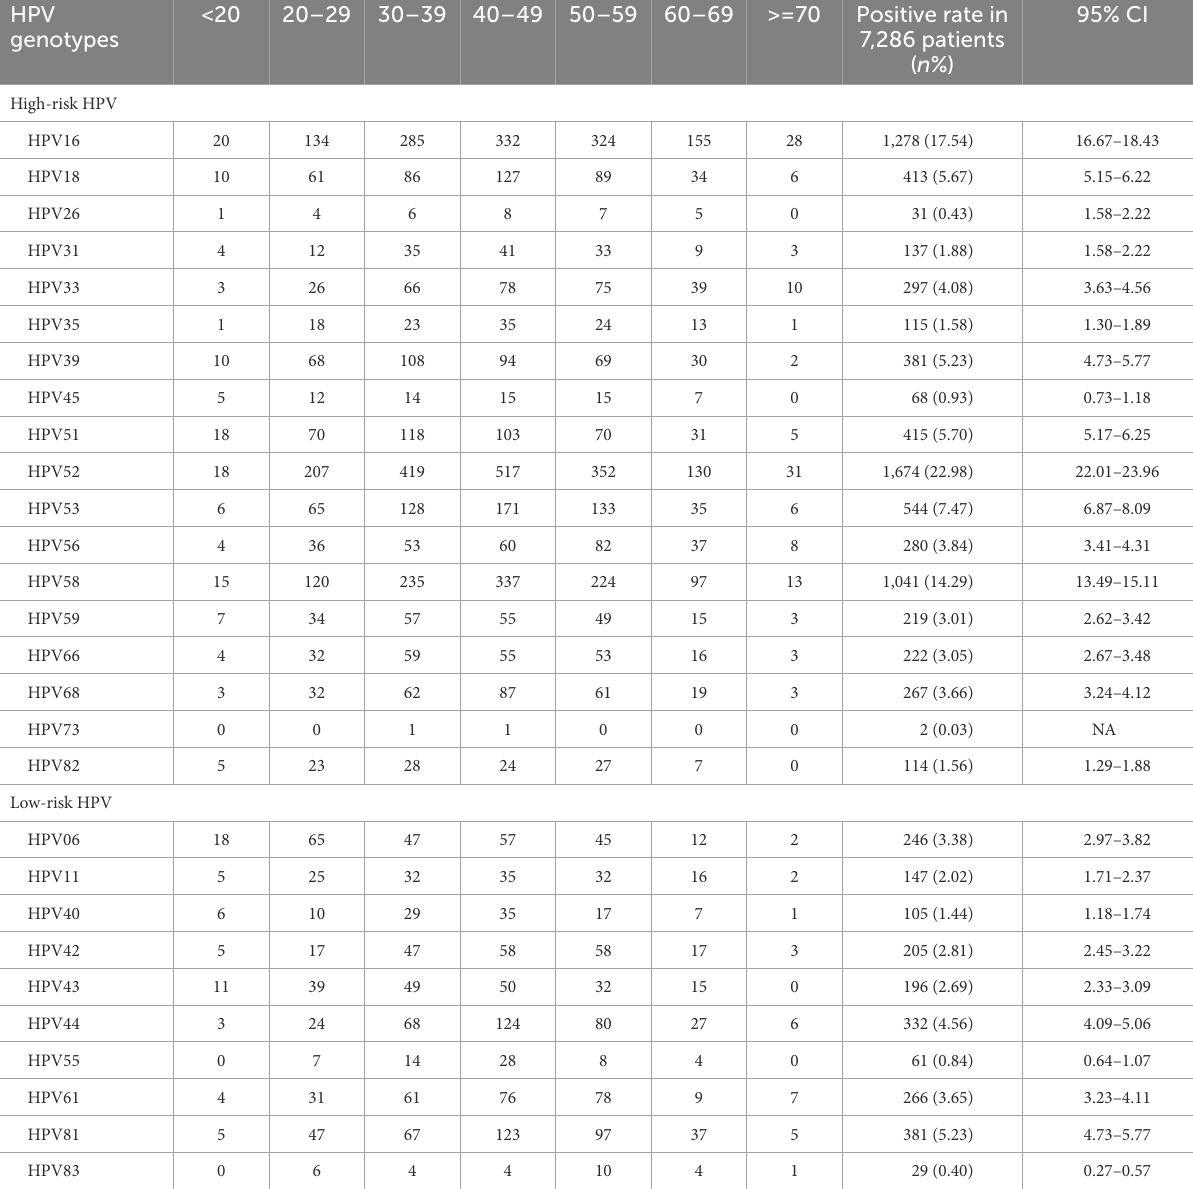
TABLE 2 Distribution of HPV genotypes in different age